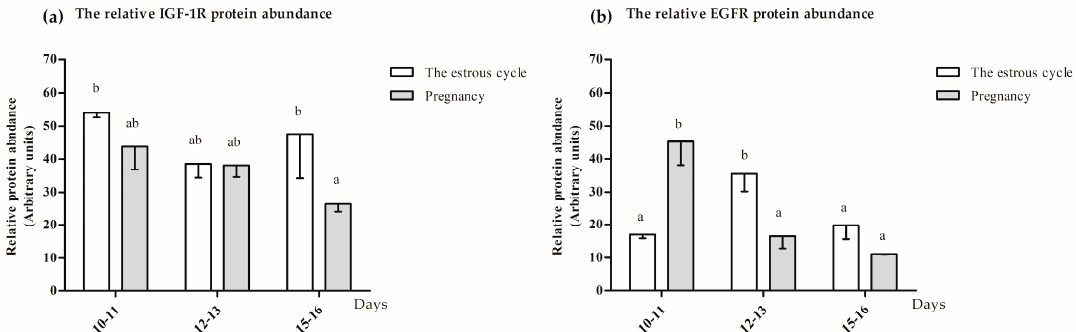
Figure 5. The relative abundance of ( a ) IGF-1R and ( b ) EGFR proteins in the myometrium collected from pigs during the estrous cycle (days 10–11, 12–13 and 15–16) and corresponding days of early pregnancy (multiway ANOVA, Fisher’s LSD post hoc test). Statistically significant differences were considered at p ≤ 0.05 and indicated as lower-case letters (a,b) above the bars.